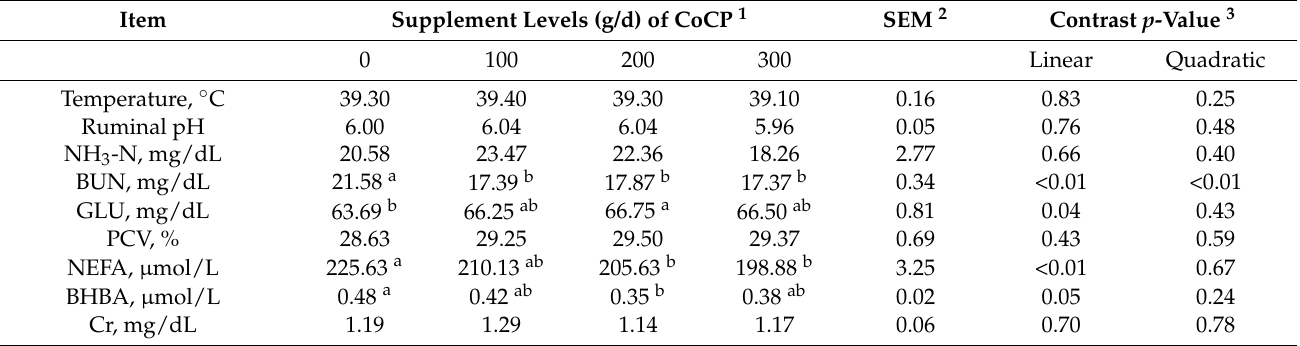
Table 3. Effects of dietary CoCP supplementation (g/d) on the rumen fermentation and blood metabolites in